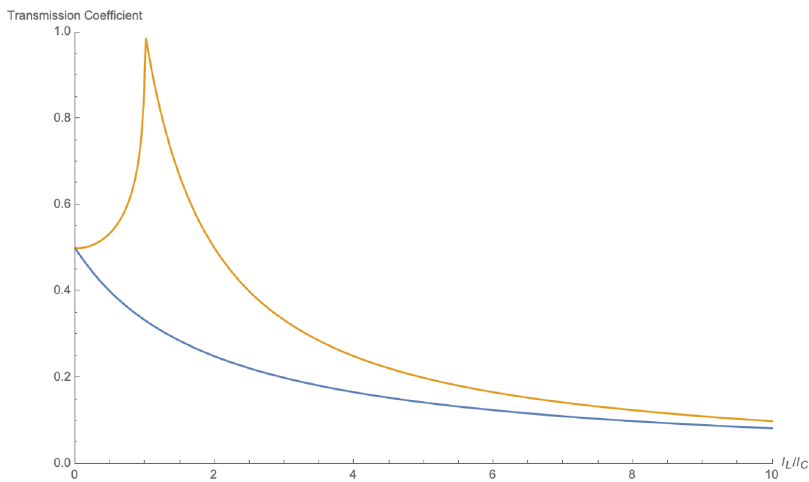
Figure 4 . The upper and lower bound of the transmission coefficient for the 3-region holographic model with the same boundary radius. As l c → 0 both upper and lower bound go to